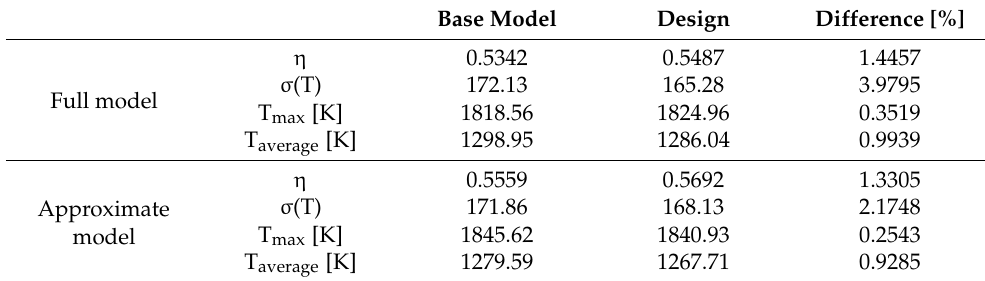
Table 5. Results of the cooling hole arrangement